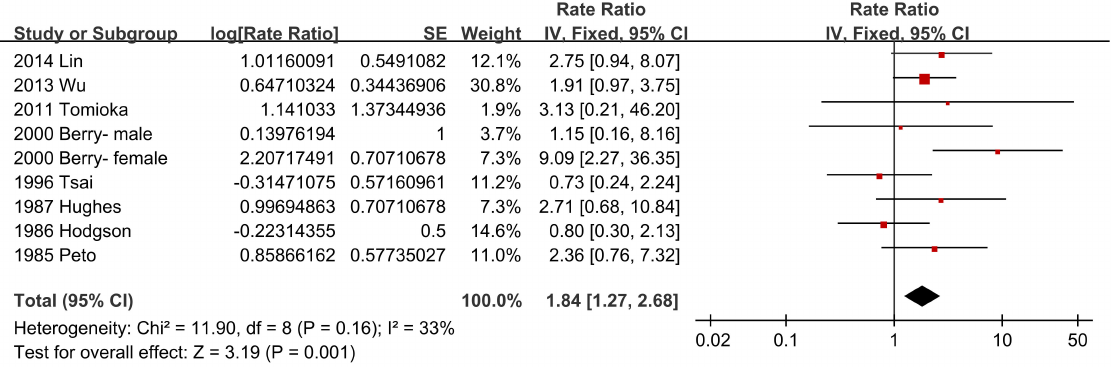
Figure 9. Subgroup analysis of SMRs of esophageal cancer in the highest asbestos exposure